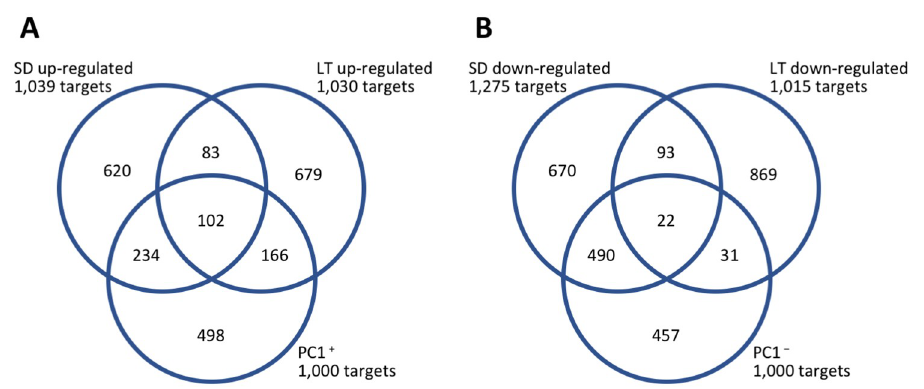
Fig 4. Comparison of genes regulated under SD and LT conditions and top 1,000 positive and negative scoring targets of principal component 1. Expression of targets with positive scores for principal component 1 increased in winter, and expression of targets with negative scores increased in summer; refer to Fig 2.